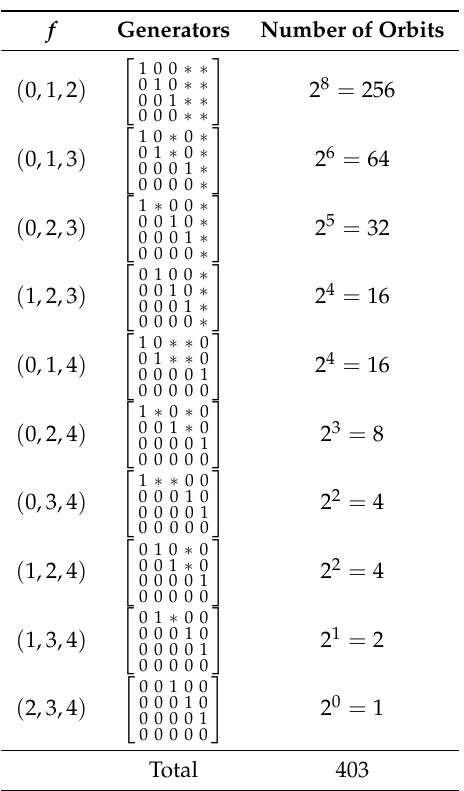
Table 1. Generators and number of